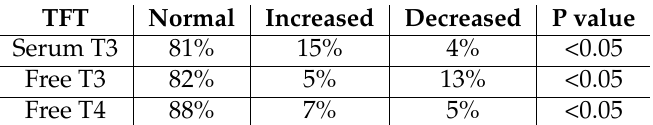
Table 2. Thyroid function test in diabetes mellitus patients